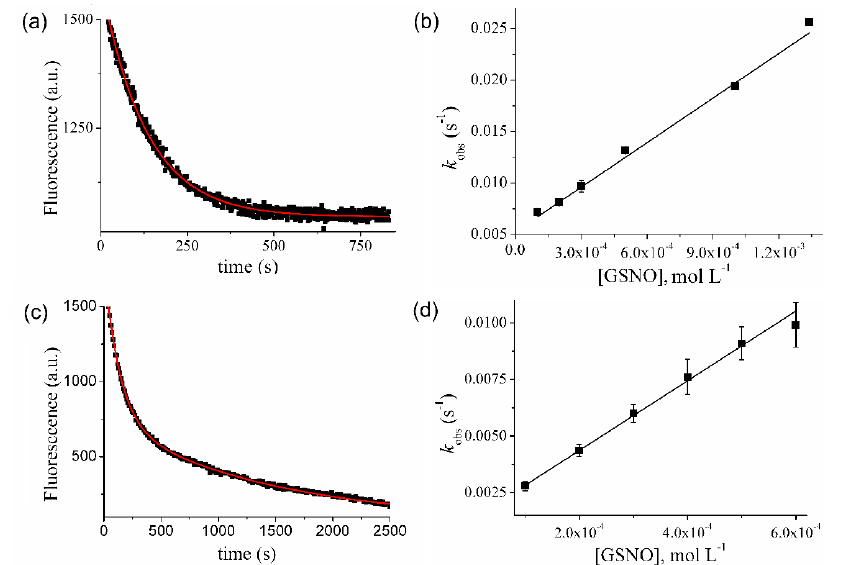
Figure 2. Kinetics of GSNO-mediated nitrosation of Prx1C83SC173S and of Prx1. ( a ) Representative kinetics of reduced Prx1C83SC173S (5 µ M) S-nitrosation by GSNO (400 µ M) ( λ exc. = 280 nm; λ em. = 330 nm). The red trace corresponds to the fitting of the data to a single-exponential function. ( b ) Determination of the second-order rate constant of the reaction of Prx1 catalytic cysteine (Cys 52 ) with GSNO. Pseudo-first-order rate constants ( k obs ) were plotted against GSNO concentration and the second-order rate constant obtained from the slope. ( c ) Representative kinetics of reduced Prx1 (5 µ M) S-nitrosation by GSNO (400 µ M). The red trace corresponds to the fitting of the data to a double-exponential function. ( d ) Determination of the second-order rate constant of the reaction of wild type Prx1 Cys 83 with GSNO. Pseudo-first-order rate constants ( k obs ) for the second-exponential fluorescence decay were obtained by fixing the first-exponential fluorescence decay to the k obs value obtained from the Prx1C83SC173S and GSNO reaction. Then, the k obs values were plotted against GSNO concentration and the second-order rate constant obtained from the slope. All the experiments were performed using a Hitachi F-2500 fluorimeter in phosphate buffer (50 mM) containing DTPA (0.1 mM), pH 7.4, at 25 °C.